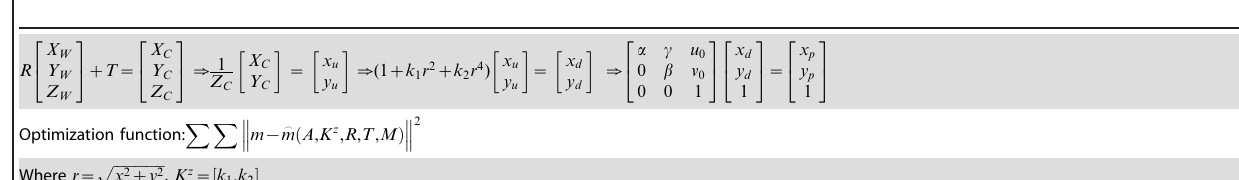
Table 1. Zhang’s calibration model.